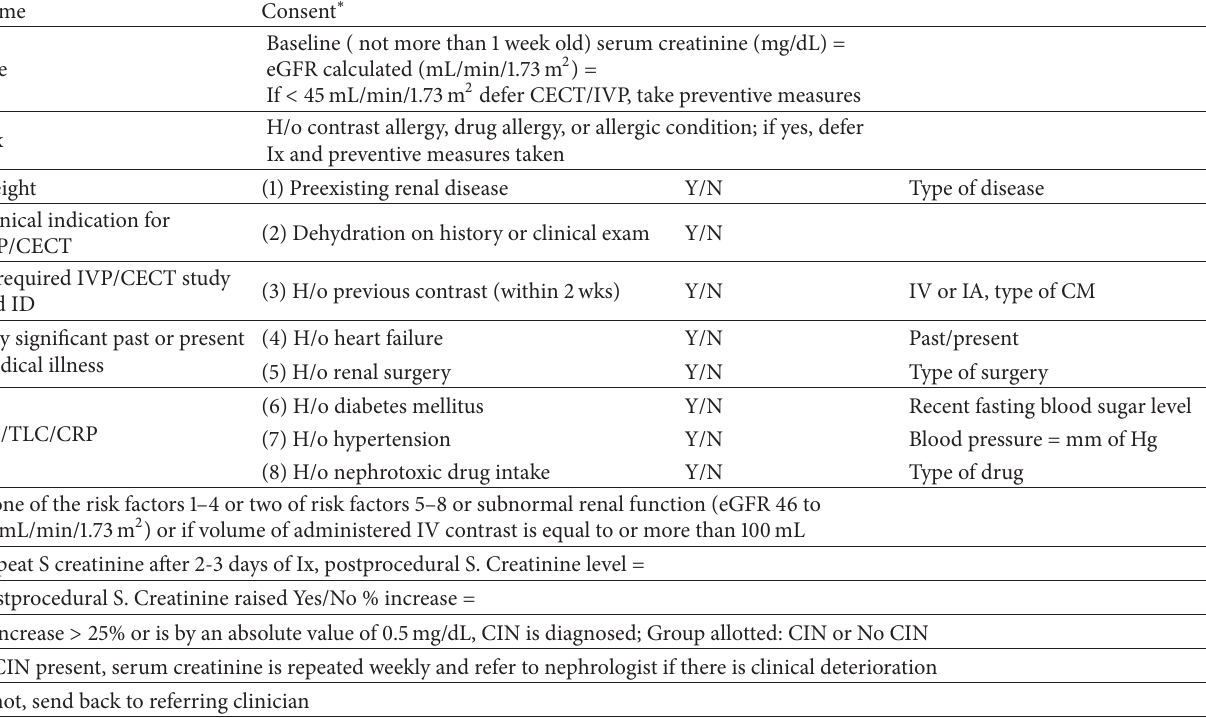
Table 4: Recommended requisition form for contrast enhanced investigations in our